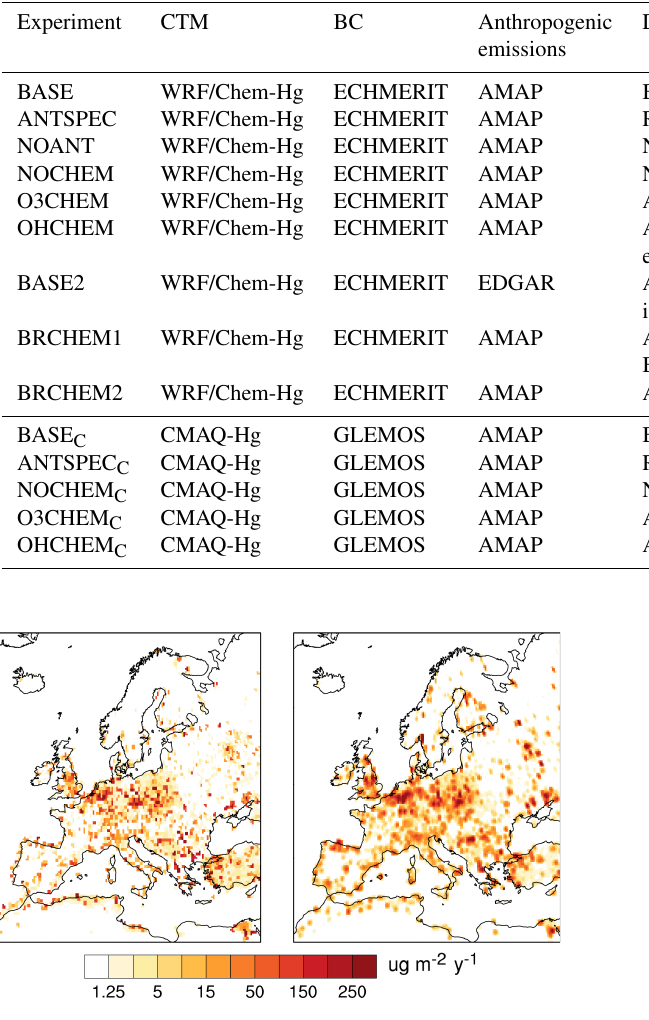
Figure 2. The anthropogenic Hg emissions used in the model ex- periments: AMAP (left panel) and EDGAR (right